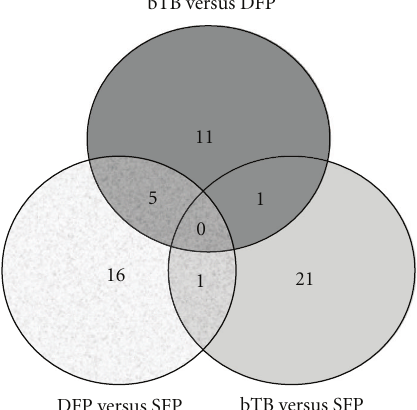
Figure 1: Number of genes from microarray analysis that were dif- ferentially expressed ( P ≤ 0 . 01) within single antemortem test-false positive (SFP), double antemortem test-false positive (DFP), and bTB-infected (bTB) groups of cattle. The RNA used for microarray analysis was harvested after a 4-hour stimulation of whole blood with tuberculin, and comparison of gene expression levels was with a reference pool of mRNA harvested from the blood of healthy cattle after 4-hour stimulation with tuberculin. The number of genes for each group of cattle that showed increased expression (solid box) or decreased expression (shaded box) relative to the reference pool of RNA is indicated by the figure in the boxes.